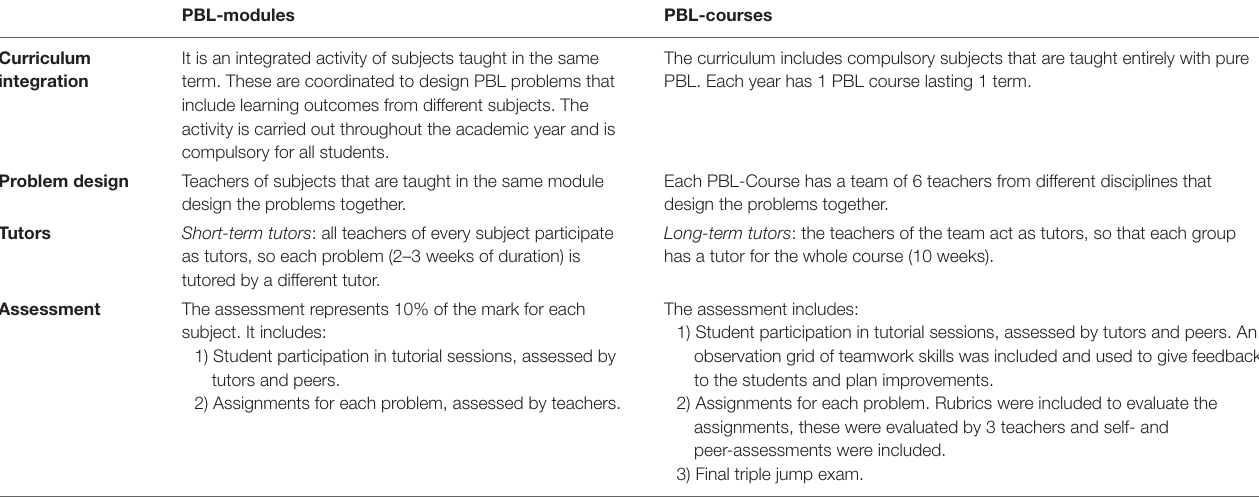
TABLE 1 | Characteristics of PBL-modules and PBL-courses.